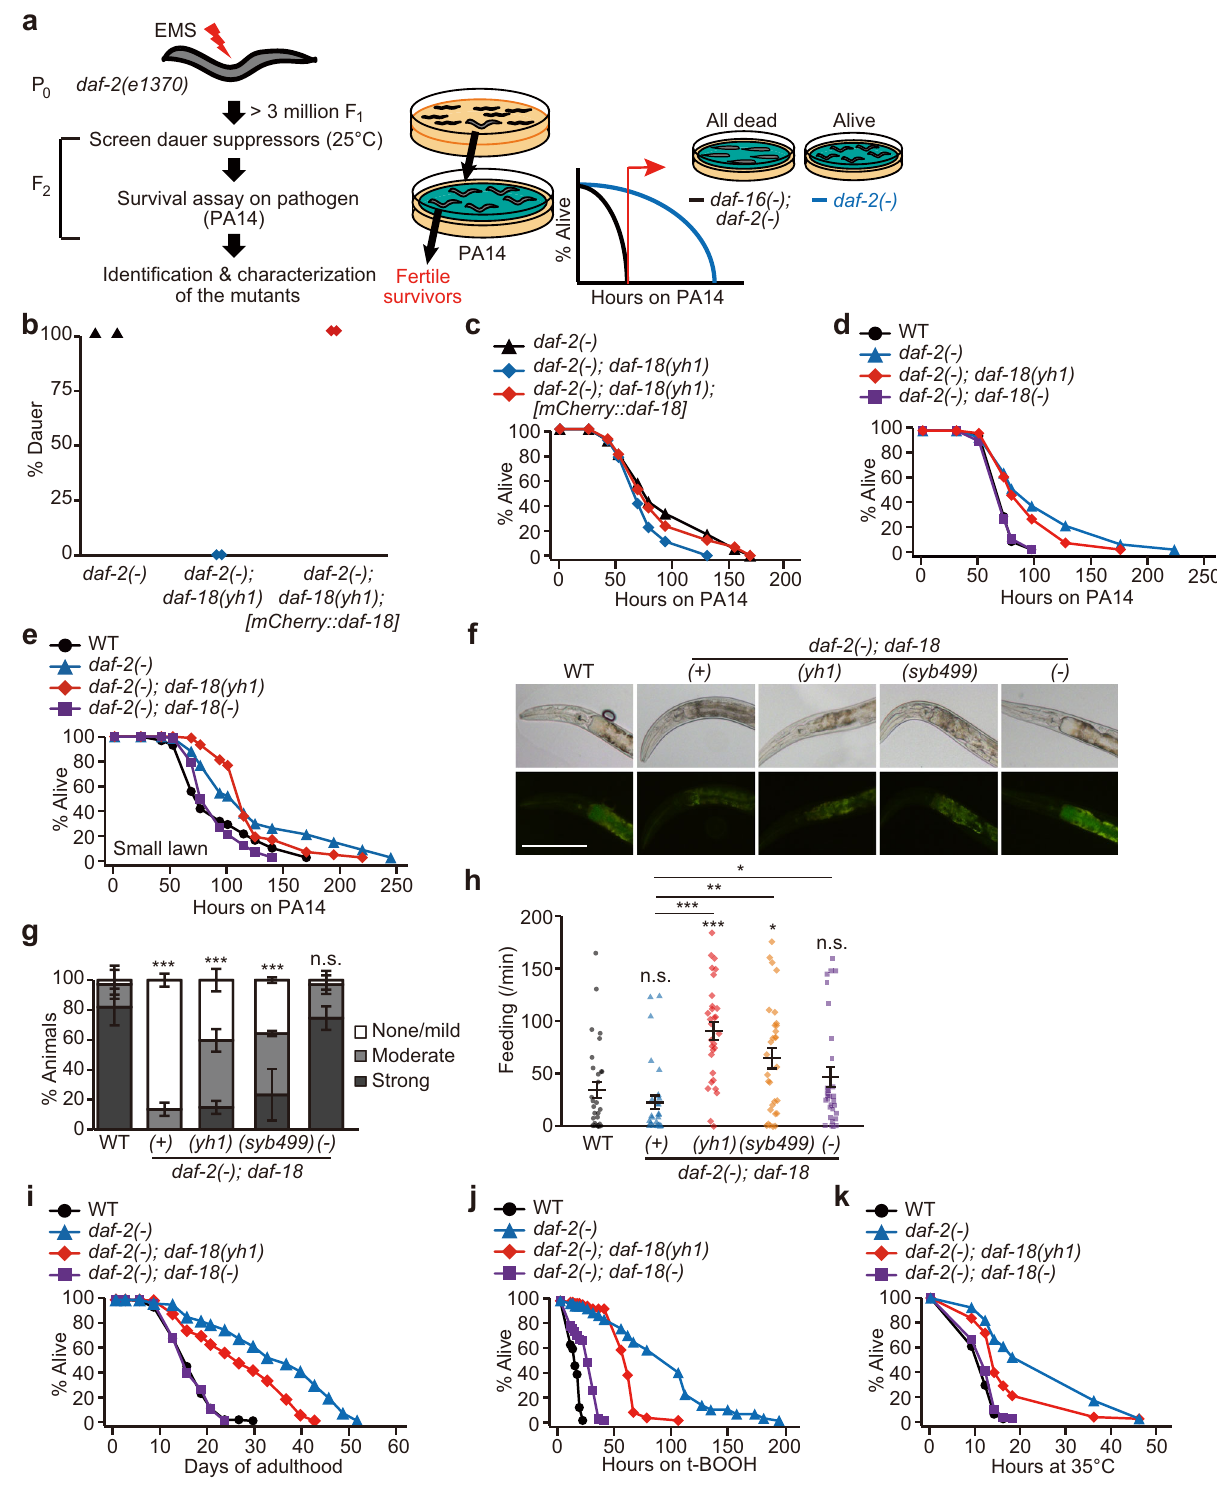
phosphoinositide 3-kinase that counteracts DAF-18/PTEN phosphatase 5,6 . We found that daf-18(yh1) partially maintained longevity and enhanced immunity in daf-2(RNAi) and daf- 2(e979) worms (Supplementary Fig. 3a, b, e, f), but did not in daf- 2(e1368) or age-1(hx546) mutants (Supplementary Fig. 3c, d, g, h). These results suggest that daf-18(yh1) can maintain lifespan and pathogen resistance in animals with reduced IIS caused by genetically inhibited daf-2 with multiple intervention modes, not NATURE COMMUNICATIONS| (2021) 12:5631